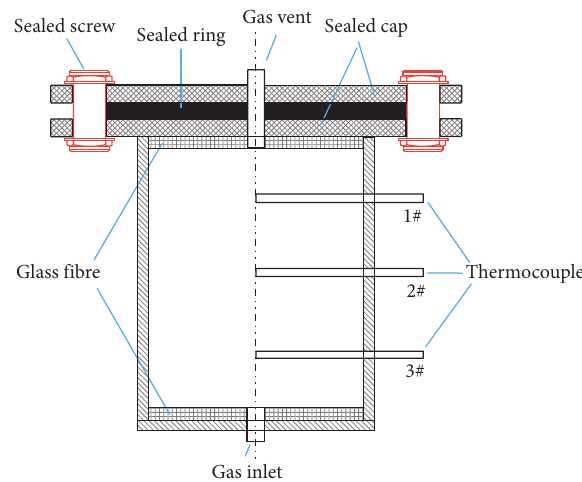
Figure 5: Details of the self-made coal sample